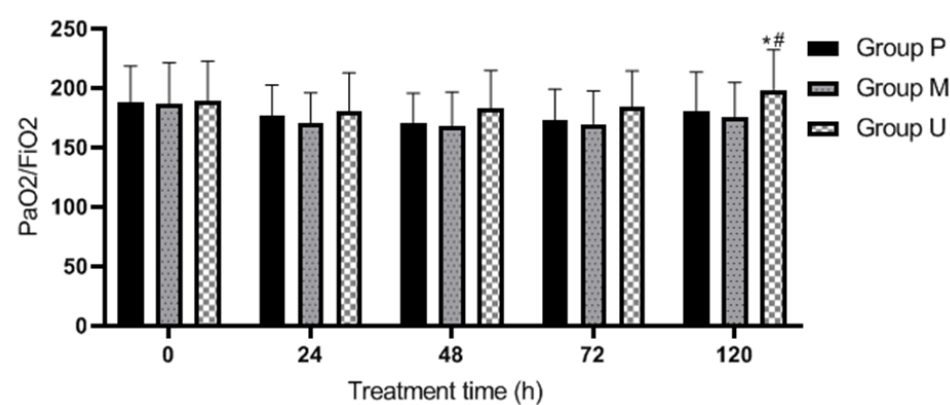
FIGURE 1 - Comparison of PaO